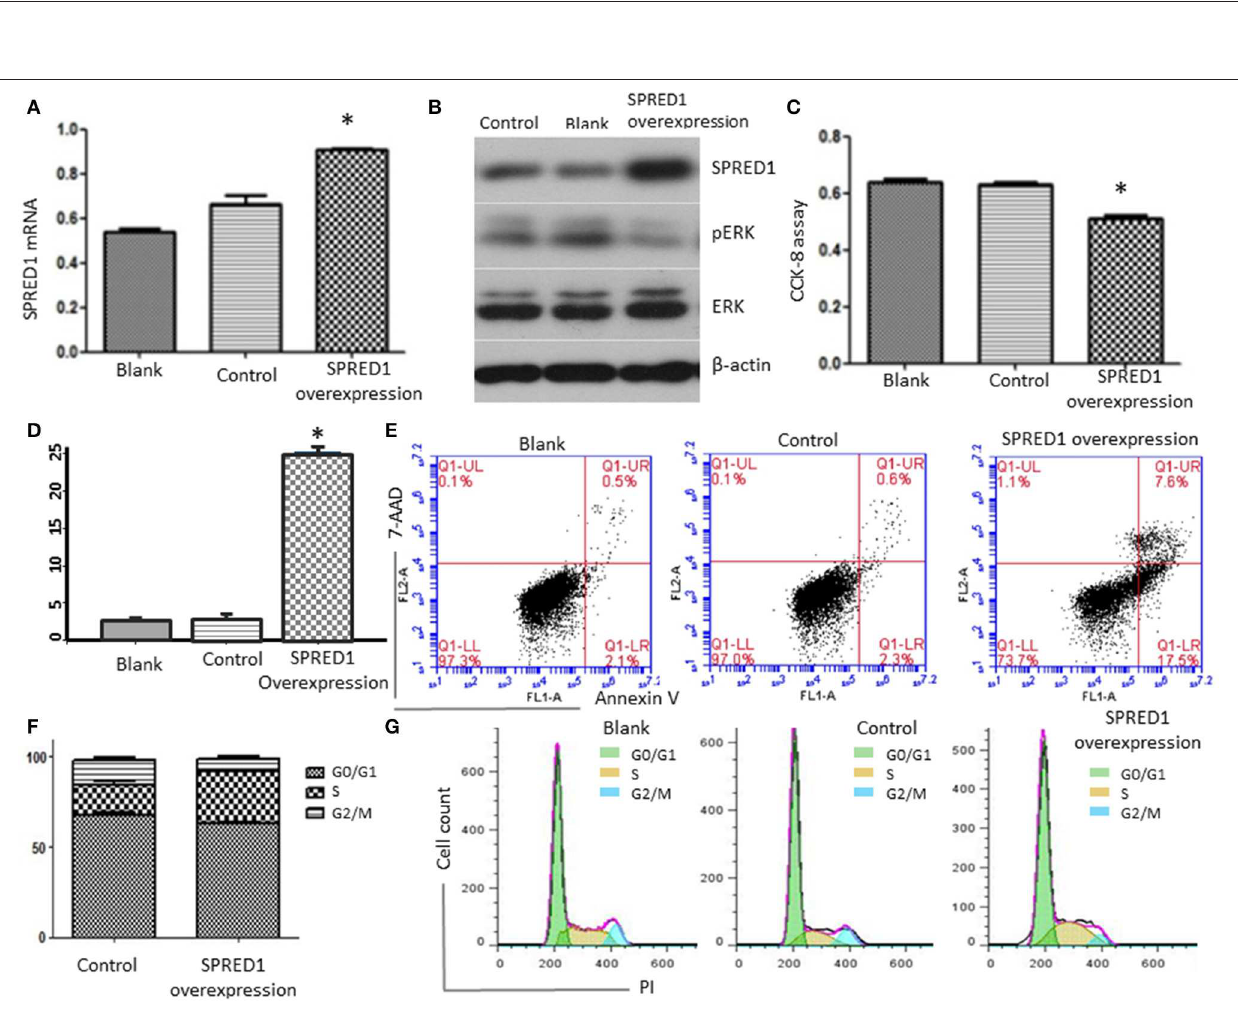
Frontiers in Oncology | www.frontiersin.org